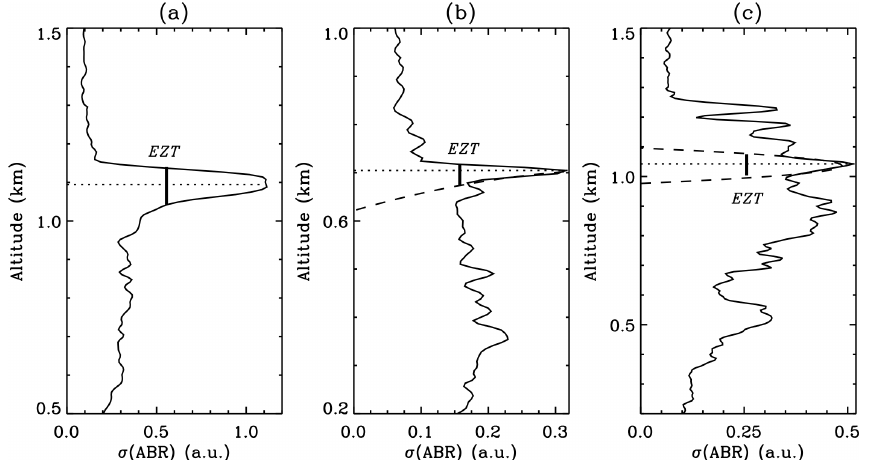
Figure 3. Illustrations of the FWHM method using the variance of ABR fluctuations to determine the CBL depth and subsequent EZT. Thin black lines indicate the standard deviation of ABR fluctuations, σ (ABR). Thin dotted lines specify the CBL depth with maximum σ (ABR). Thick vertical lines represent the determined EZT (EZ). (a) For a strong updraft case, both the upper and lower edges near the peak σ (ABR) are clear-cut and steep. The EZT can be directly obtained. (b) For a less-intense updraft case, the lower edge is not clear-cut enough. A quadratic polynomial fitting (dashed line) is applied to the lower edge to help determine the EZT. (c) For a weak turbulence and advected aerosol case, neither the upper nor the lower edge is clear-cut enough. Quadratic polynomial fittings (dashed lines) are applied to both edges to help determine the